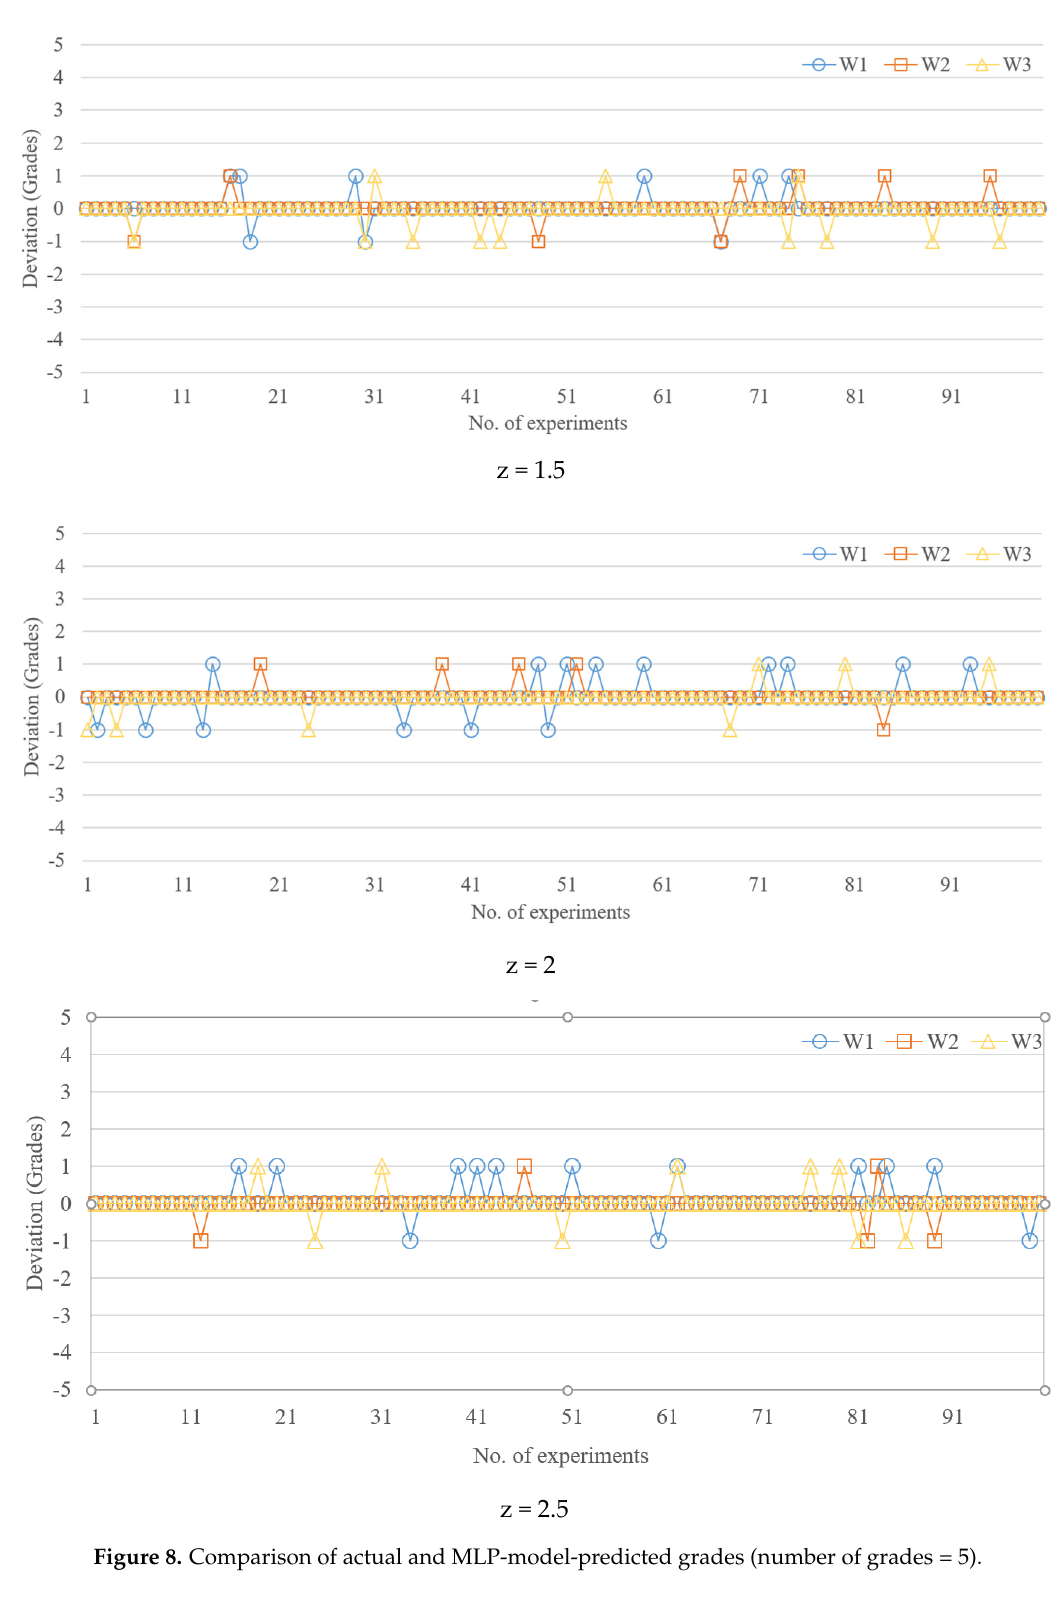
Figure 8. Comparison of actual and MLP-model-predicted grades (number of grades = 5). Table 8. Relation of average, standard and maximum deviation in three width, z-scores and grades.